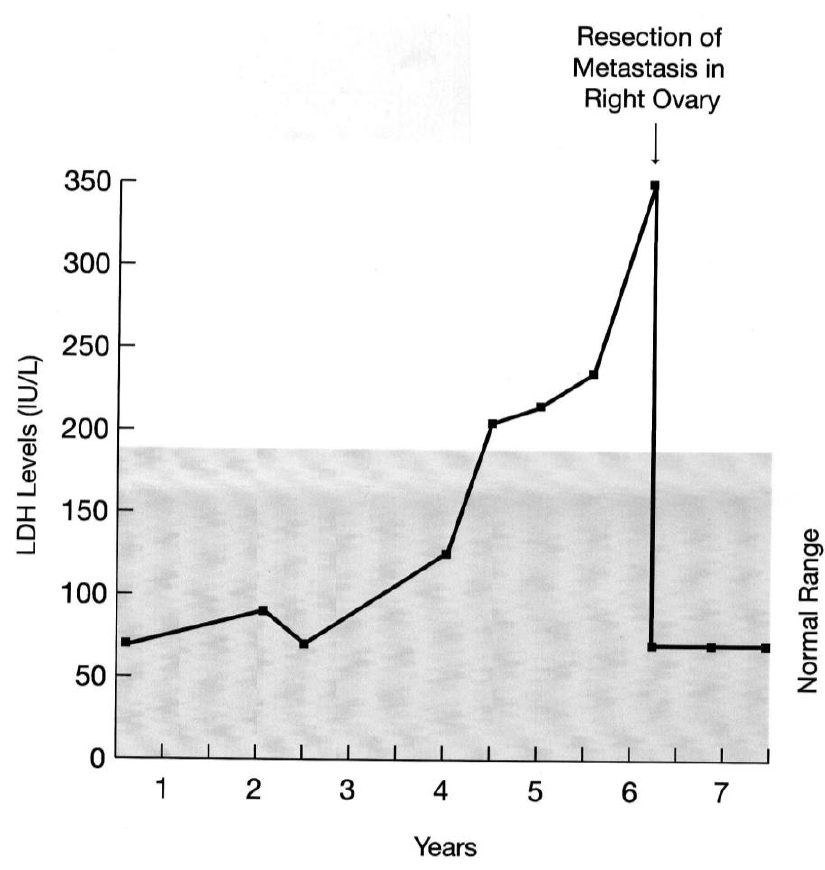
Figure 1. A diagram showing consecutive determinations of serum lactate dehydrogenase (LDH) in a woman with history of resected cutaneous melanoma. Her serial determinations of serum LDH started to rise almost one year before her left ovarian metastasis was diagnosed and resected. Note the precipitous drop in serum LDH level post-operatively. In addition, she received adjuvant autologous vaccine. She is alive and free of disease for over 23